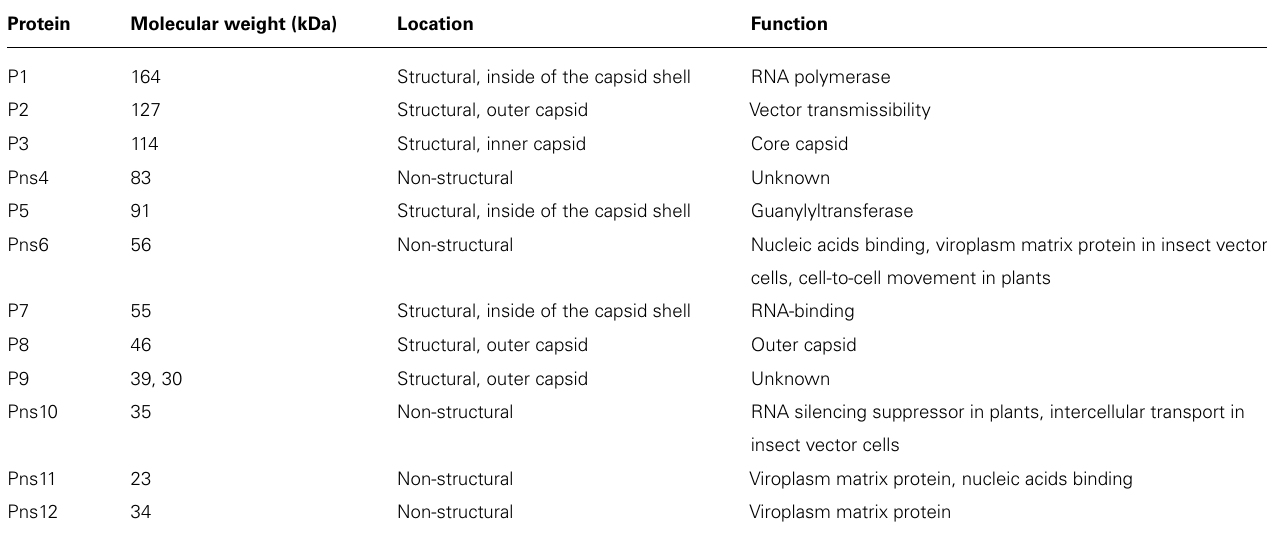
Table 1 |Viral proteins of Rice dwarf virus